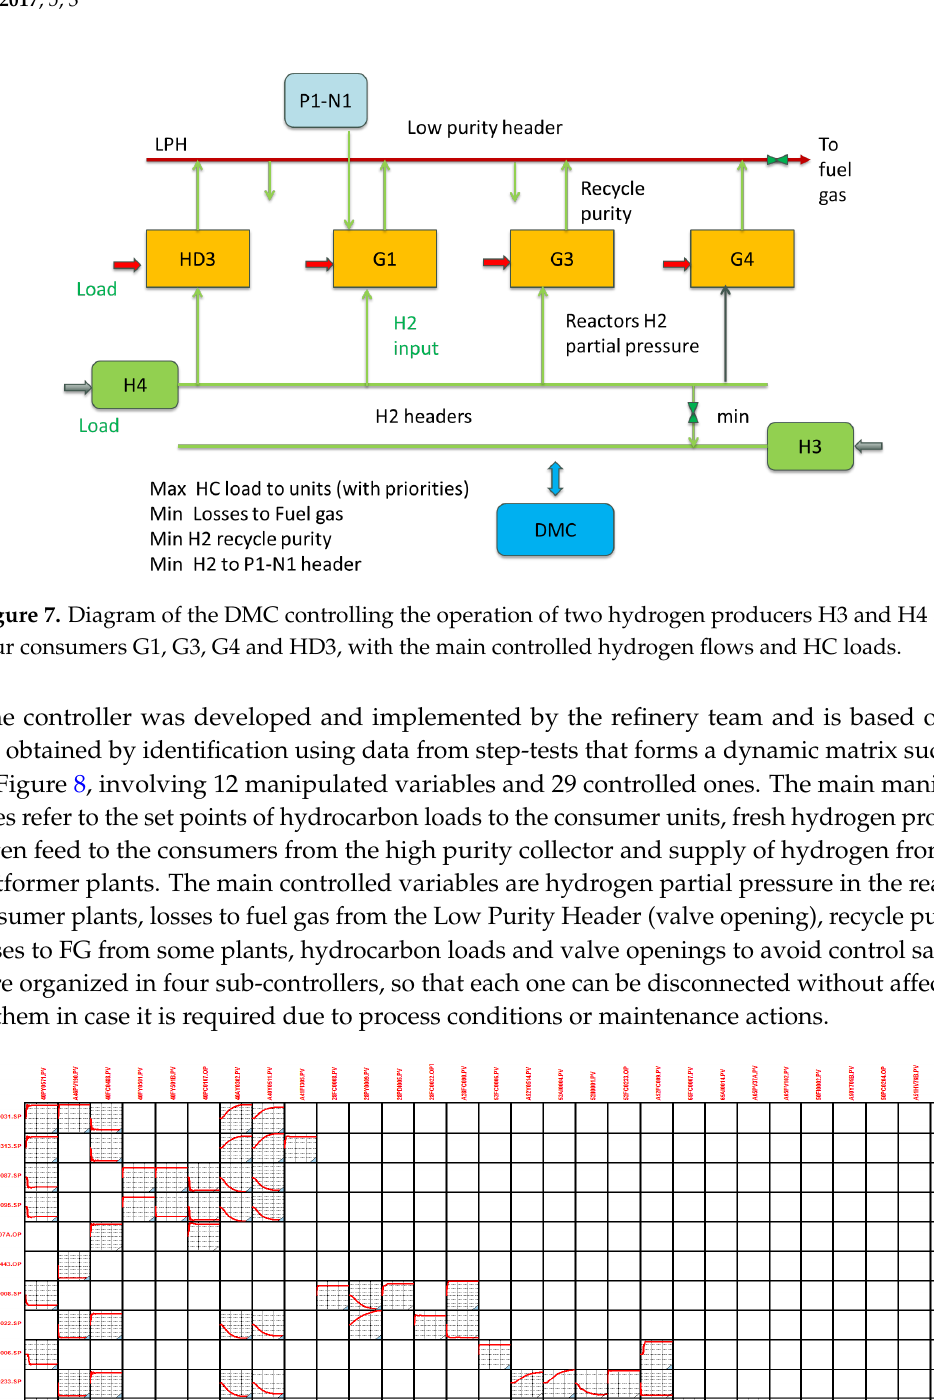
Figure 8. Dynamic matrix of the DMC controller.